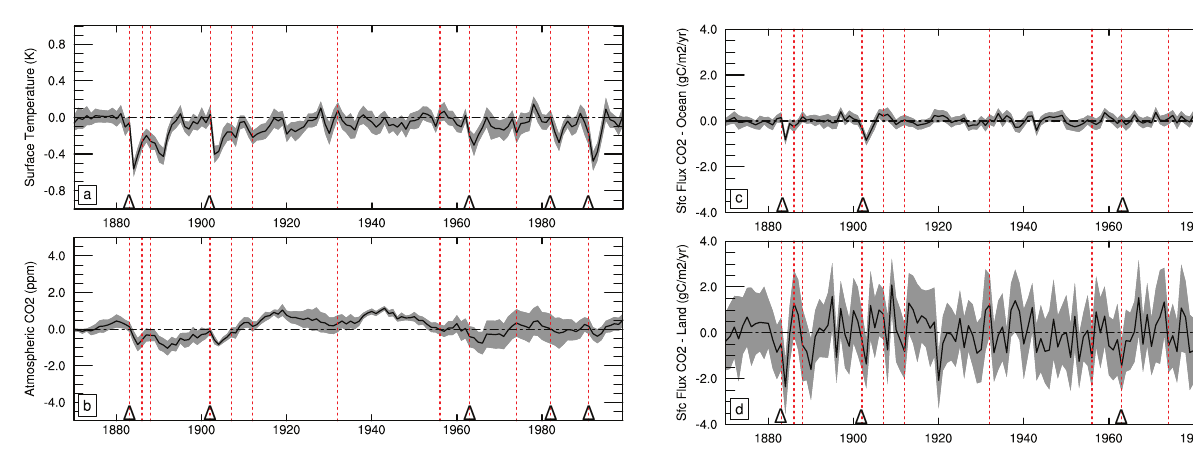
Fig. 1. Globally averaged yearly anomalies for surface tempera- ture (a) , CO 2 (b) , surface flux of carbon to ocean (c) and land (d) from a coupled carbon–climate model, the CCSM3. The model in- cluded prescribed volcanic aerosol and prognostic sulfate and car- bonaceous aerosol with corresponding emissions and anthropogenic forcings. Shaded area indicates one standard deviation (computed from ensembles of paired runs) above and below anomaly, and dashed vertical red lines indicate years with eruptions from Table 1, with the 5-eruption subset denoted by triangle glyphs. Significant drops in surface temperature and flux of carbon to the land and ocean occur after multiple eruptions (negative flux indicates a flux from the land/ocean to the atmosphere), while there is not as coher- ent of a signal in the atmospheric CO 2 record. The CO 2 in the runs plotted here is fully prognostic.